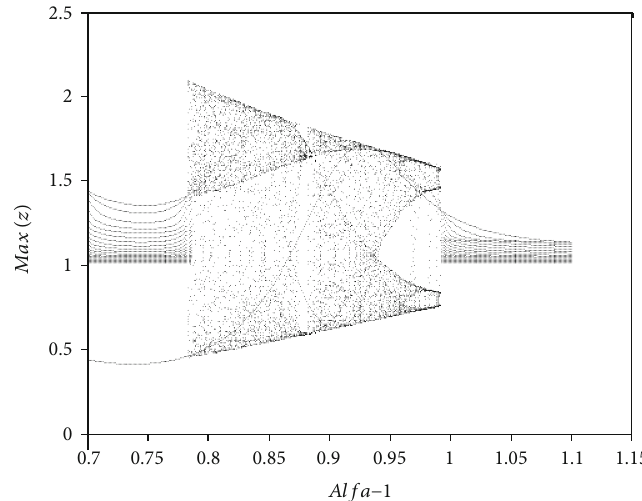
0 : 7 < α < 1 : 1 using the parameter values in (90). 1 in the range 1